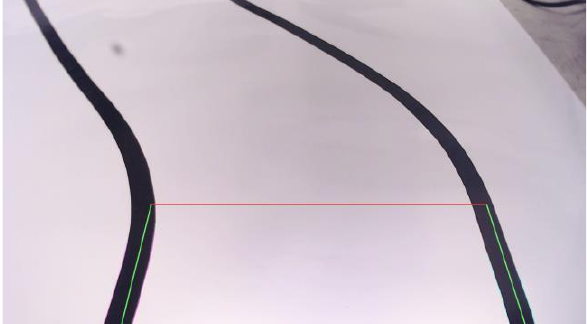
Fig. 6. An example of a model self-driving car as a computer science and engineering project.